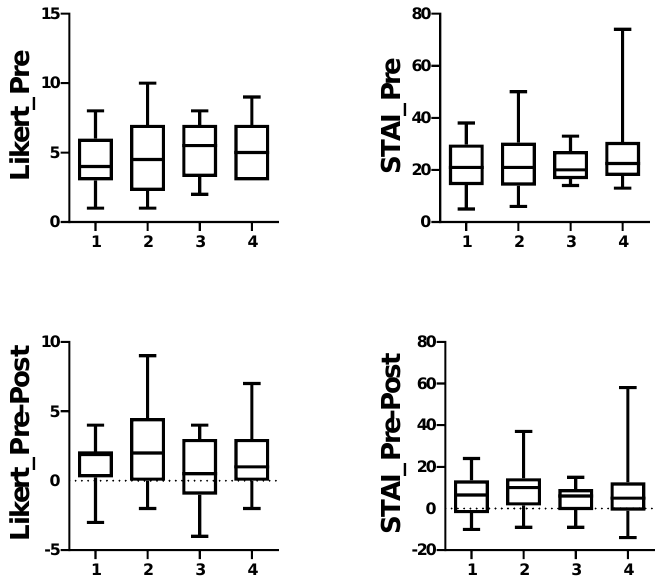
Figure 4. Boxplots representing median, interquartile, and range data of Likert (Likert_Pre) and STAI (STAI_Pre) data before activity; and the difference after-before of Likert (Likert_Pre-Post) and STAI (STAI_Pre-Post) data reported by students. Group 1 included students that showed a decrease in both sAA and cortisol after the activity ( ↓ sAA & ↓ cortisol); Group 2 included students that showed a decrease in sAA but an increase in cortisol ( ↓ sAA & ↑ cortisol); Group 3 included students that showed an increase in sAA and a decrease in cortisol concentrations ( ↑ sAA & ↓ cortisol), and Group 4 included students that showed an increase in concentration of both sAA and cortisol after the activity ( ↑ sAA & ↑ cortisol).